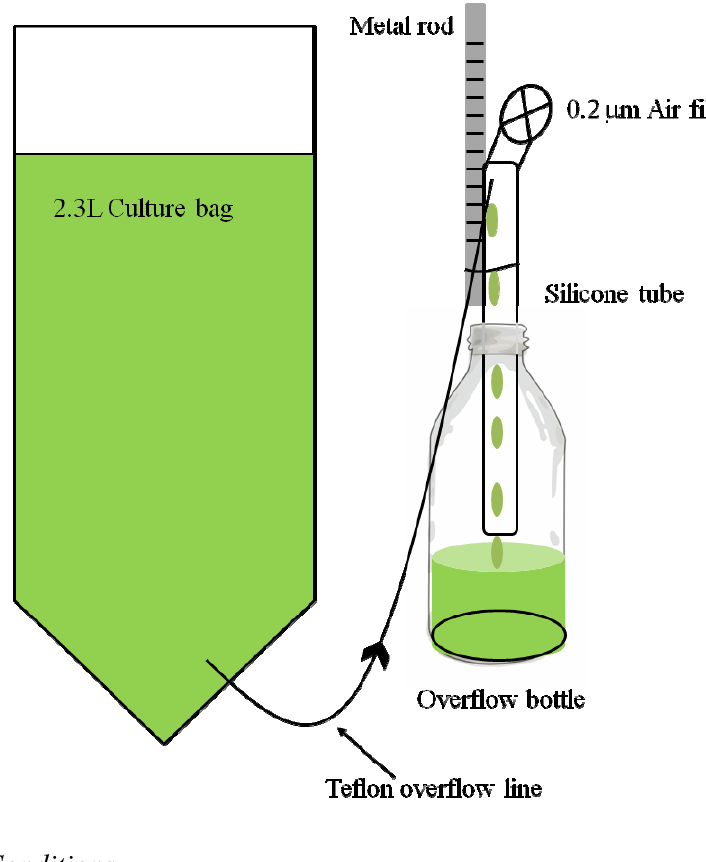
Figure 2. Schematic diagram of a culture bag and its attached overflow bottle. As the peristaltic pump added media to the bag, excess culture flowed through the 1 mm Teflon overflow line into a silicone tube and dripped from there into the overflow bottle. The height of the top of the Teflon overflow line relative to the culture bag controlled the flow rate of culture out of the bag: the lower the tip of the Teflon line compared to the culture bag, the greater the flow rate. The position of the Teflon overflow line was adjusted by moving it up and down a metal rod, fastened next to each overflow bottle. Individual adjustment of the outflow relative to the constant rate of influx from the peristaltic pump (Figure 1) could be used to determine the overall volume of each culture bag. The silicone tube was open to the outside pressure via a 0.2 µm air filter to prevent the culture from siphoning out of the culture bag. For simplicity air lines and air outlets are not included in this